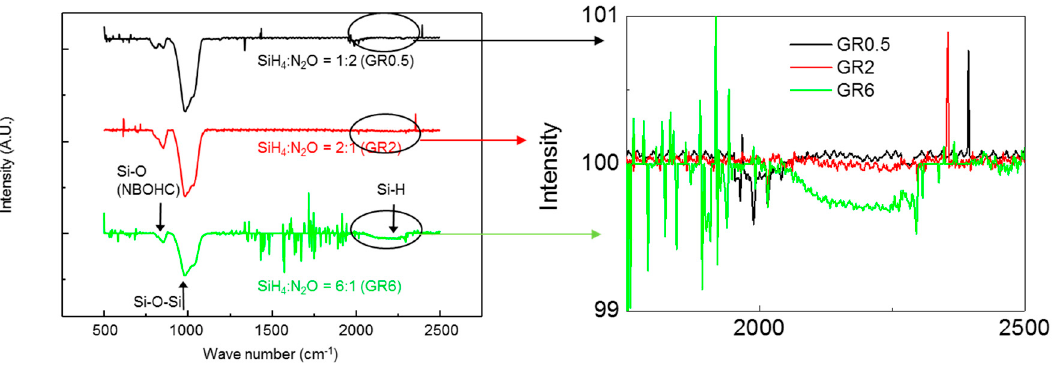
Figure 2. The FT-IR transmittance spectroscopy of the SiO X layer as a charge trapping layer with different SiH 4 :N 2 O gas ratio (GR).